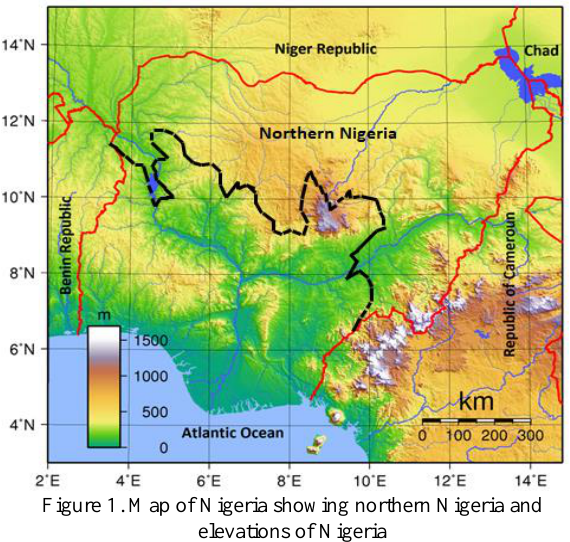
Figure 1. Map of Nigeria showing northern Nigeria and elevations of